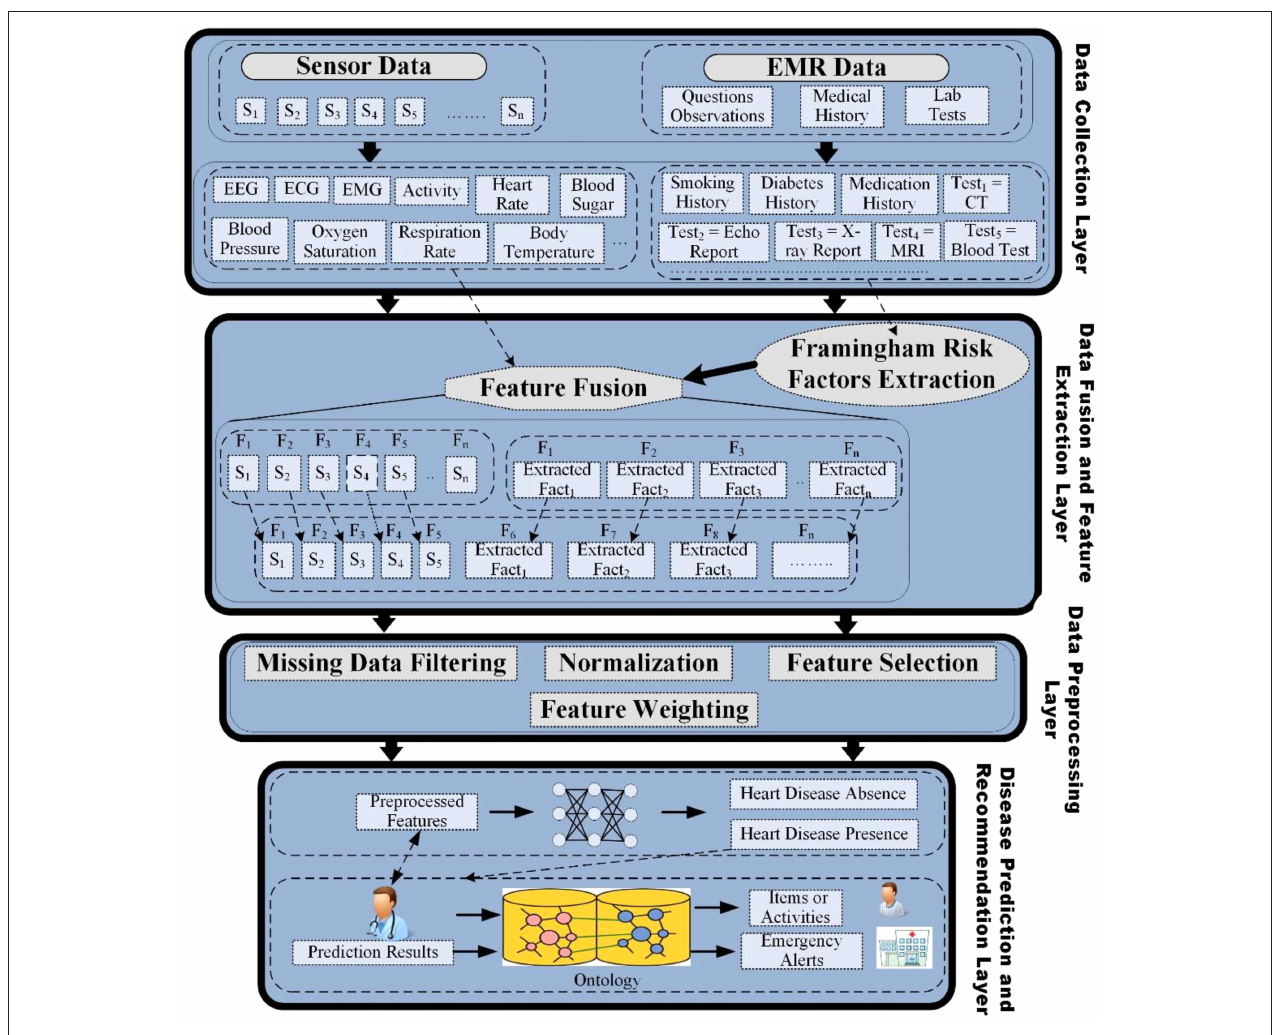
FIGURE 4 | Information framework for heart disease prediction and recommendations. Figure taken from Ali et al.